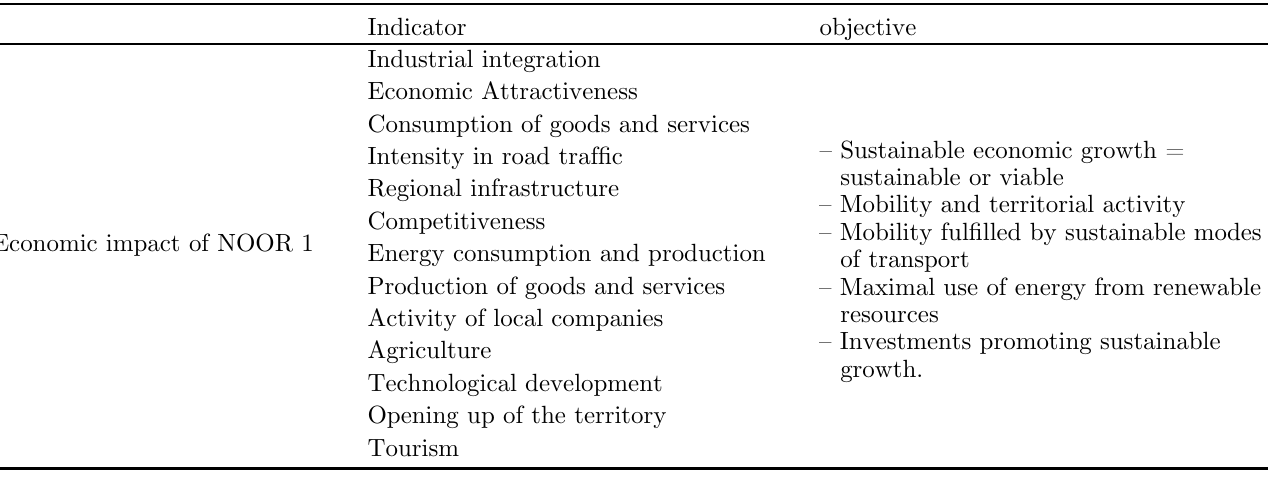
Table 1. Economic development indicators used in the qualitative analysis.